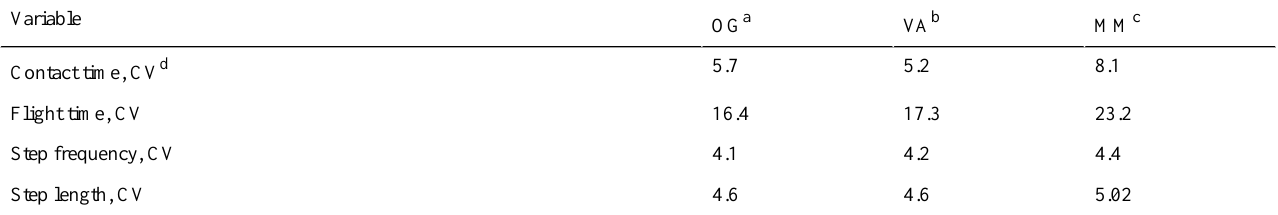
Table 2. Coefficients of variation (%) of spatiotemporal parameters during running at 12 km/h obtained from three different